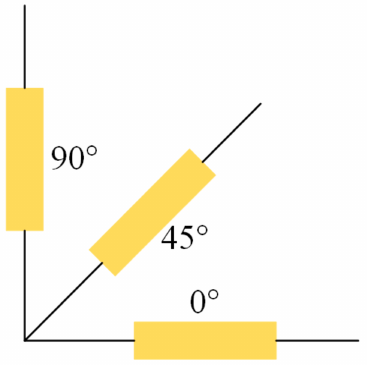
Figure 11. A schematic diagram of a 45 ◦ rectangular strain